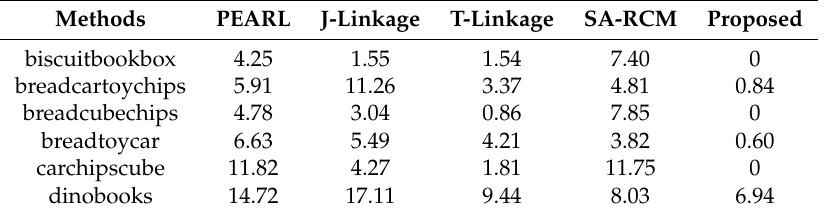
Table 2. Misclassification (%) for the multi-fundamental matrix